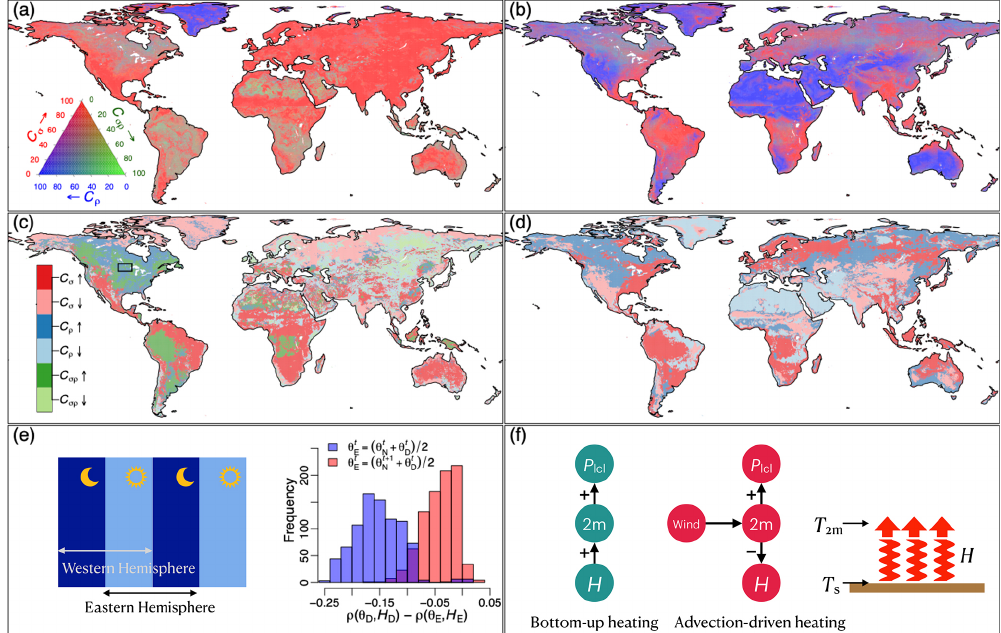
Figure 4. Comparison between TLM D and TLM E . Left panel: the land leg ( L ); right panel: the atmospheric leg ( A ). Top row: fractions of the three components of (cid:49) | M | ( | M D |−| M E | , Eqs. 8 and 9, see Sect. 2.5). Red, blue, and green indicate contributions of fluctuation, correlation, and joint of the two ( | C σ | , | C ρ | , and | C σρ | ), respectively (see Sect. 2.5). Middle row: primary contributor to pattern shift in TLM (see Sect. 2.6). The legend contains three pairs of colors: red, blue, and green indicate C σ , C ρ , and C σρ as the primary contributors, respectively. A darker (lighter) color indicates a quantile increase (decrease) from E to D. Left panel of (e) : conceptual figure showing the combinations of daytime and nighttime that make up the E time series in the Eastern versus Western Hemisphere. Right panel of (e) : histograms of the difference between D- and E-based ρ (θ,H) . Data are from the rectangle region shown in (c) . The blue histogram indicates the cases with the original θ E (an average of the nighttime soil moisture θ N and the following daytime soil moisture θ D ). Red histogram indicates the cases with the modified θ E (an average of the θ D and the following θ N ). Left and middle panel of (f) : two mechanisms driving the A . Right panel of (f) : the definition of sensible heat flux H which reflects the temperature gradient from the surface to the near surface